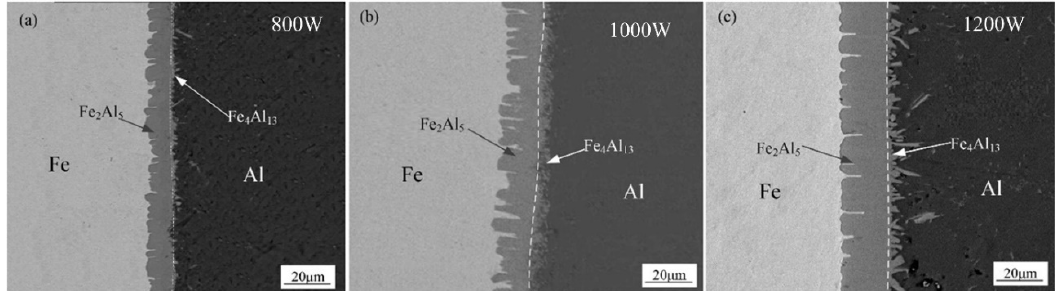
Figure 6. Interfacial micromorphology with different laser power: ( a ) 800 W, ( b ) 1000 W, and ( c ) 1200 W.